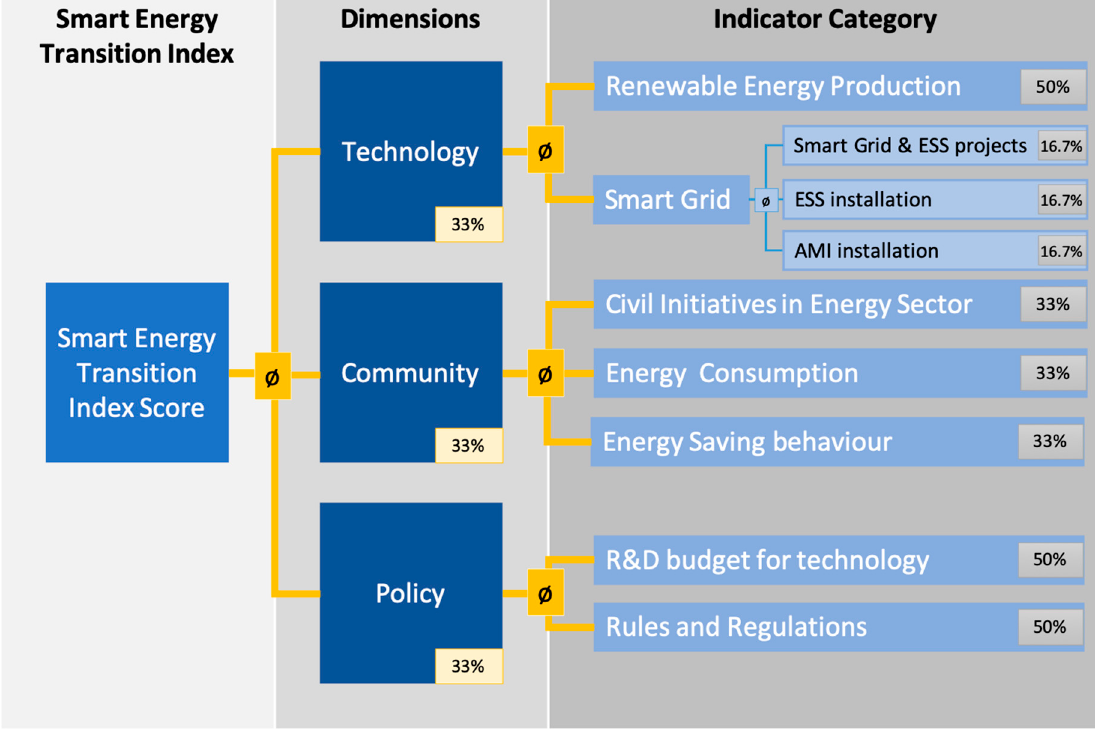
Figure 2. Constructing the Smart Energy Transition Index. Informatics 2019 , 6 , x